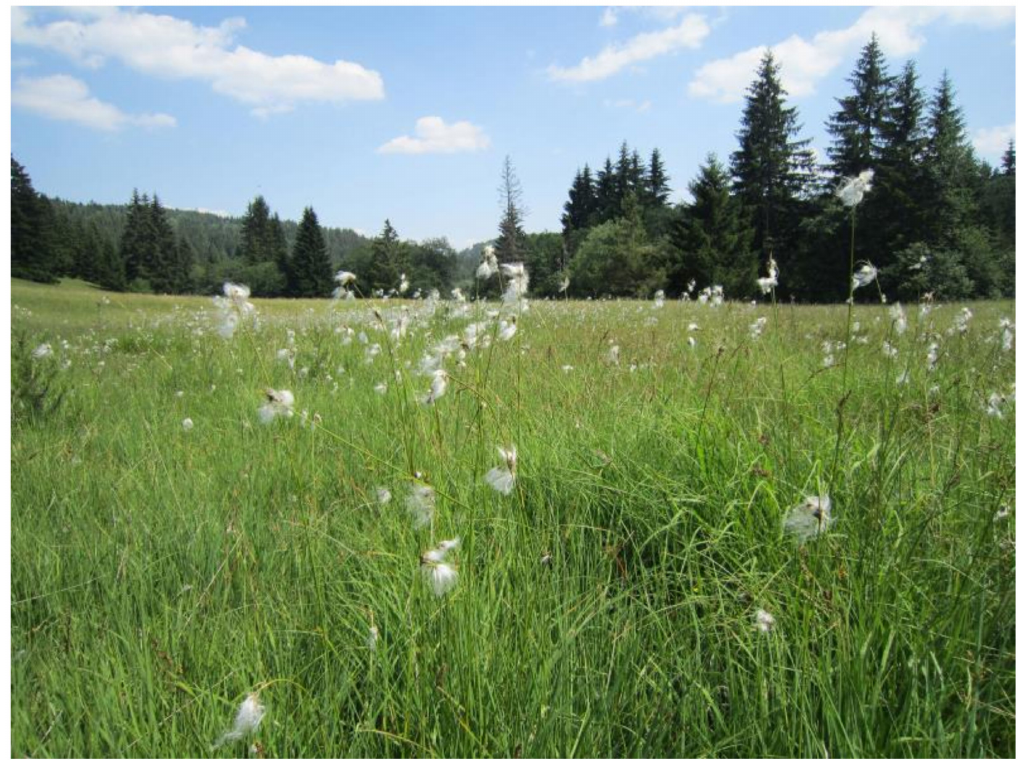
Figure 13. The association Eriophoro-Caricetum paniculatae R. Jov. 1983 (Serbia, photo V.